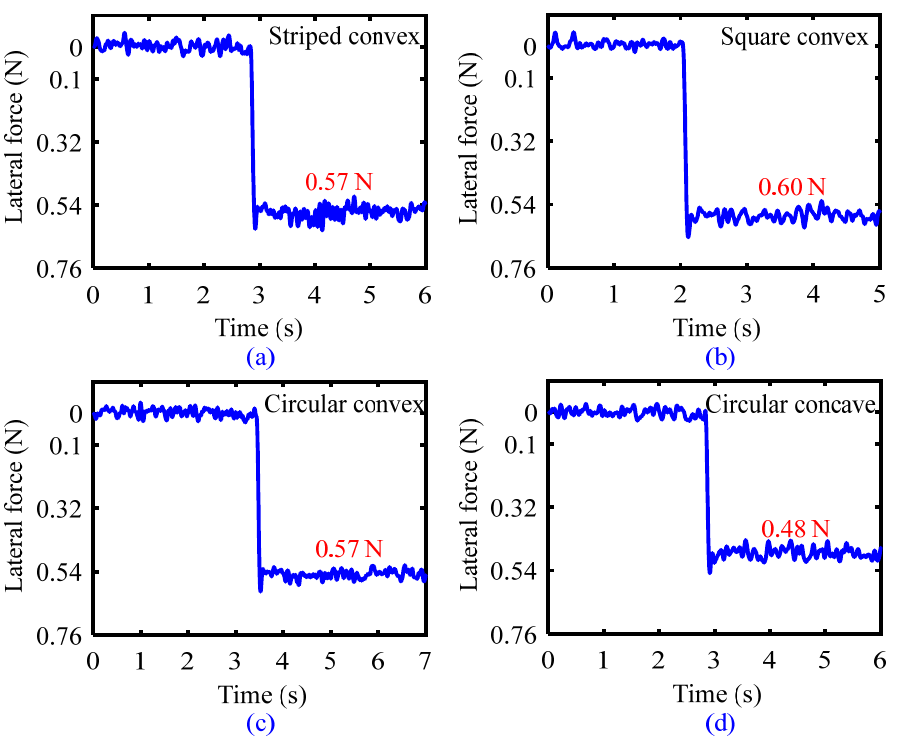
Figure 7. Lateral force–time curves of the four laser-textured driving feet: ( a ) striped convex, ( b ) square convex, ( c ) circular convex and ( d ) circular concave.